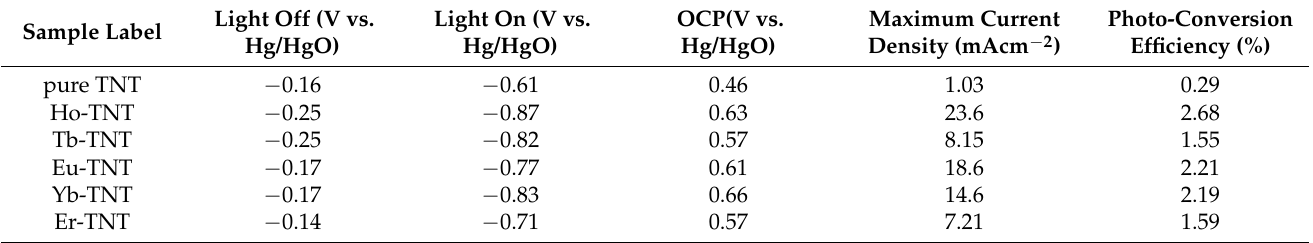
Table 3. Open ‐ circuit voltage (OCP) measurement, maximum current density and photoconversion efficiency of the samples, obtained from electrochemical analysis.